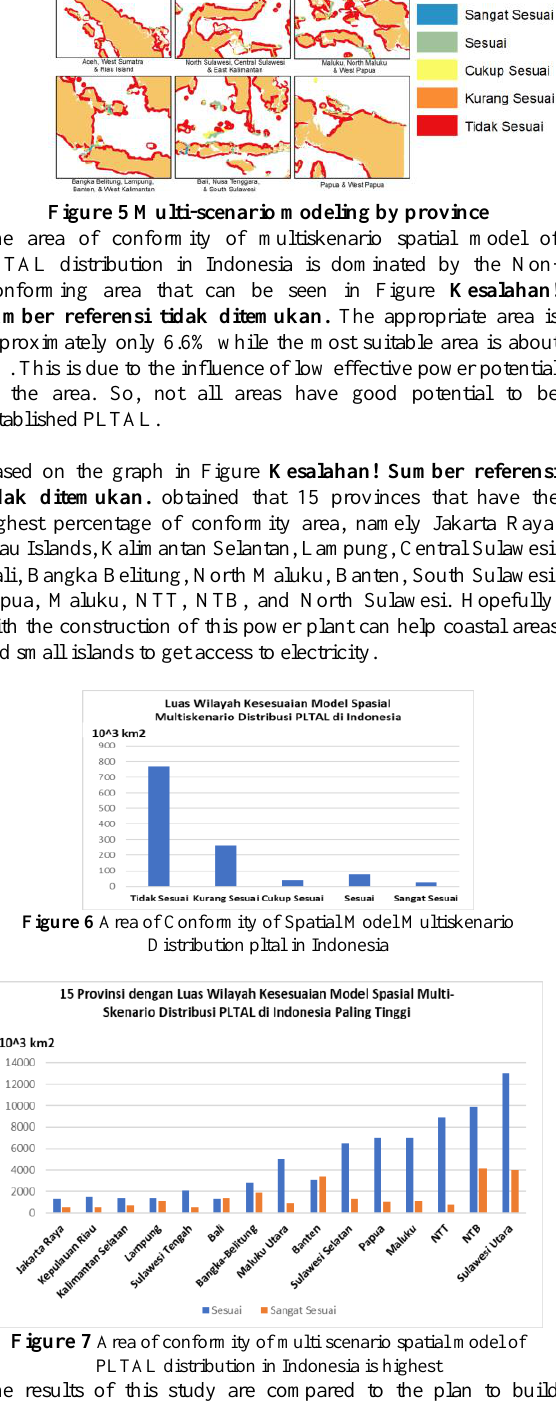
Figure Kesalahan! Sumber referensi tidak ditemukan. and Figure Kesalahan! Sumber referensi tidak ditemukan. From